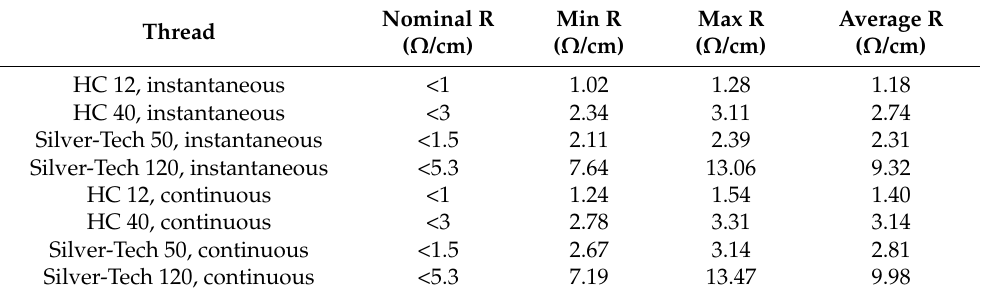
Table 3. Calculated Resistance Values of the Supplied